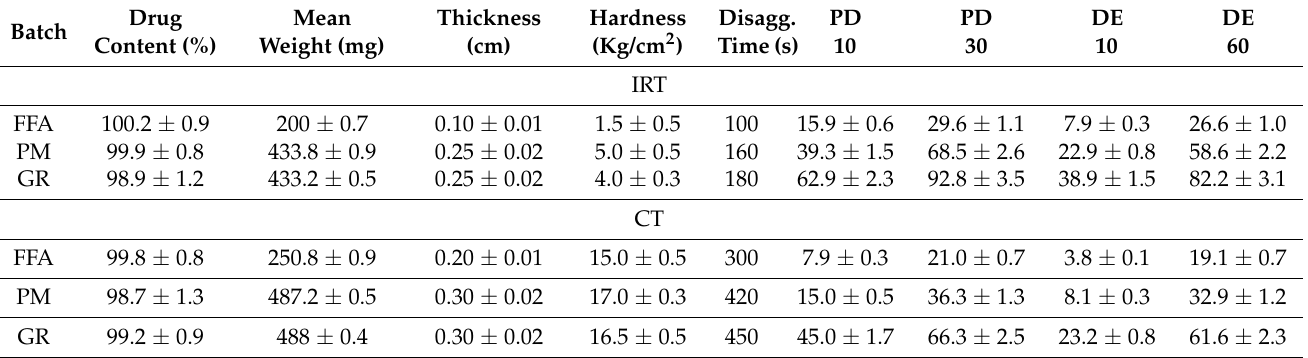
Table 3. Properties of immediate release tablets (IRT) and conventional tablets for enteric coating